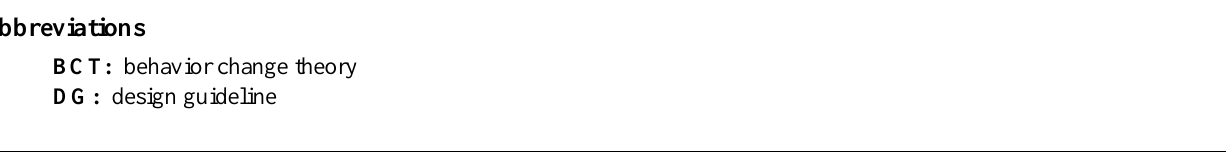
Abbreviations BCT: behavior change theory DG: design